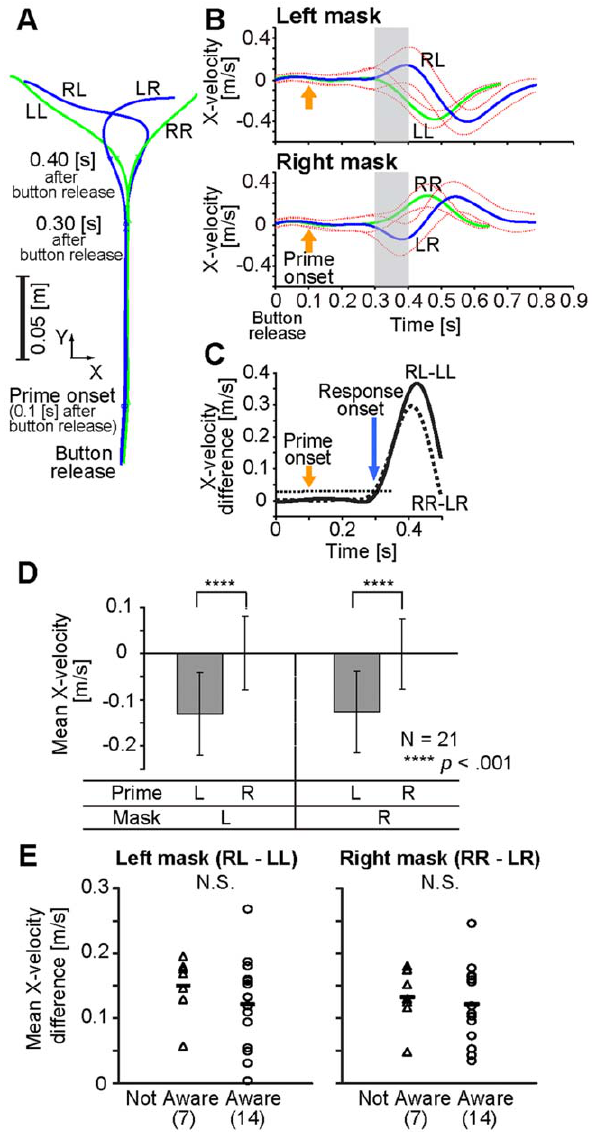
Figure 3. Kinematic properties of reaching movement. (A) Average reach trajectory to the far target of each side in each condition for a single participant. Green and blue curves show trajectories when prime-mask combinations were congruent (RR and LL conditions) and incongruent (LR and RL conditions), respectively. (B) Average X velocity profile in each far-target condition for a single participant. Green and blue curves show the velocities when the prime-mask combination was congruent and incongruent, respectively. Red dashed curves denote 6 1 SD of velocities between trials. The data were aligned at the button release. (C) Mean X velocity difference profiles (Solid: RL – LL. Dashed: RR – LR.) calculated from the pooled data to far and near targets. The velocity difference was calculated as the index of the response onset to the prime stimulus. The threshold value (dotted line) was set at 0.03 m/ s. (D) Mean X velocity of the 100-ms-time window (calculated from the pooled data to far and near targets) corresponding to the gray area in Fig. 3B (i.e., 200 , 300 ms after the prime onset) in each condition. (E) Relationship between the awareness of the association (between the participant’s own performance and the color cue) and the strength of the implicit motor control induced by the invisible stimulus. The difference of mean X velocity in the 100-ms-time window (Fig. 3D) between RL (RR) and LL (LR) conditions for each participant was calculated as the individual strength of the implicit motor control.